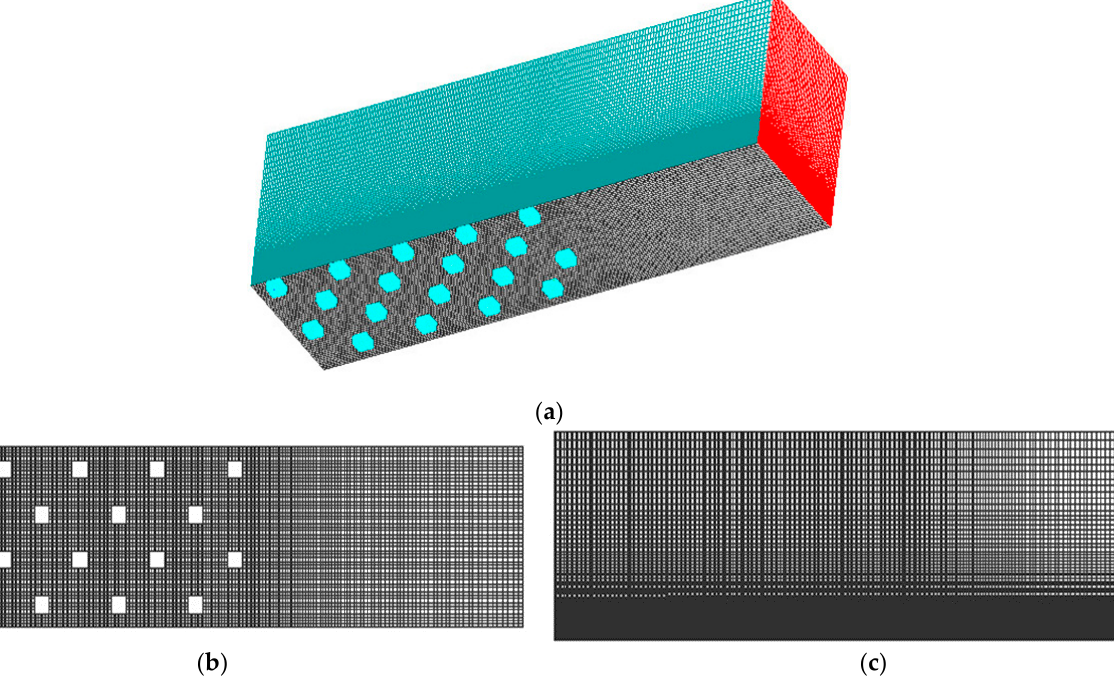
Figure 3. Gridding of the calculation domain: ( a ) The calculation domain; ( b ) The xy -plane; ( c ) The xz -plane.